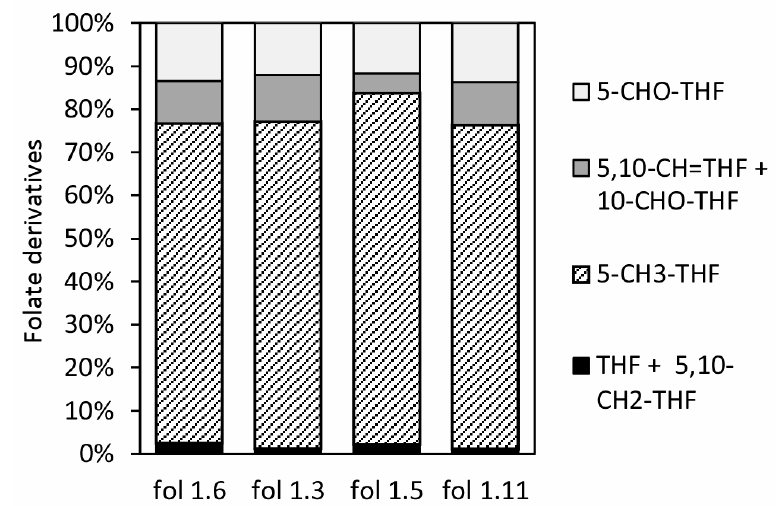
Figure 2. Distribution of folate species in potato lines harvested in November 2012. Due to the acidic pH of the mobile phase tetrahydrofolate (THF) plus 5,10-CH 2 THF, and 5,10-CH = THF plus 10-CHO-THF cannot be distinguished during the chromatography.